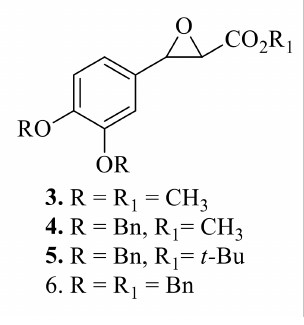
Figure 3. 2-methoxycarbonyl-3-(3,4-dimethoxyphenyl)oxirane (MDMPO) ( 3 ), 2- methoxycarbonyl-3-(3,4-dibenzyloxyphenyl)-oxirane (MDBPO) ( 4 ), 2-benzyloxycarbonyl-3-(3,4- dibenzyloxyphenyl)oxirane (BDBPO) ( 5 ), 2- t -butyloxycarbonyl-3-(3,4-dibenzyloxyphenyl)oxirane (TBDBPO) ( 6